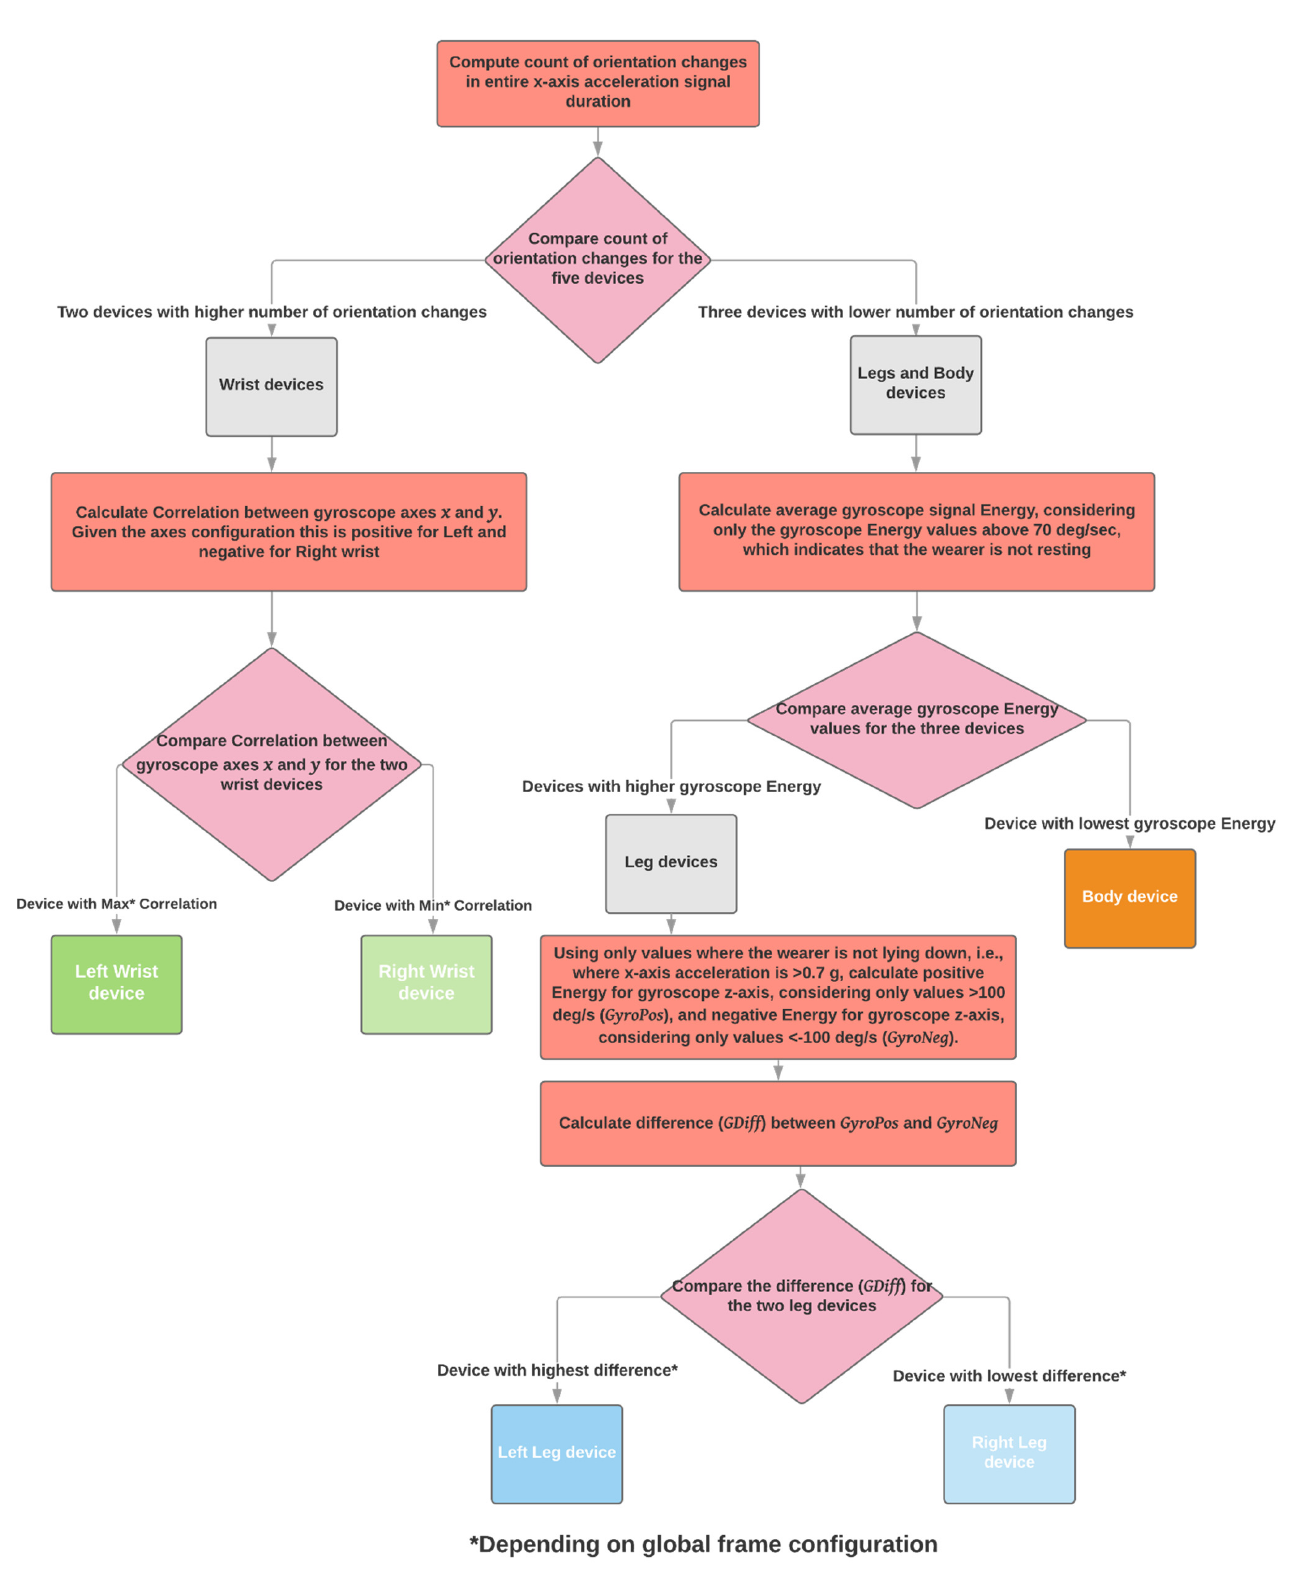
Figure 8. The automatic placement identification algorithm when five sensing devices have been used.